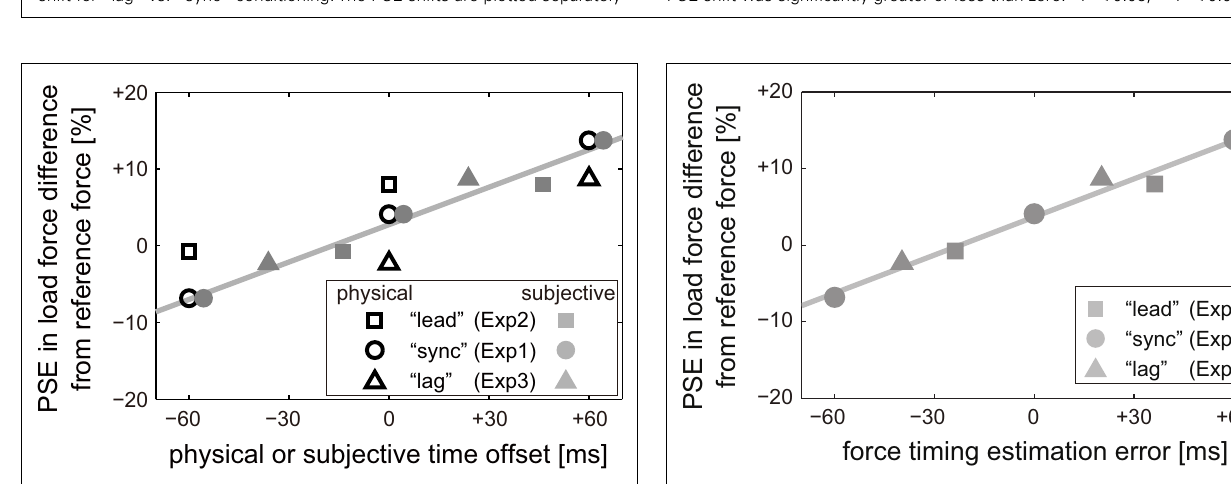
FIGURE 8 | Shift in PSE after different types of offset conditioning. (A) Box plots of PSE shift for “lead” vs. “sync” conditioning. (B) Box plots of PSE shift for “lag” vs. “sync” conditioning.The PSE shifts are plotted separately